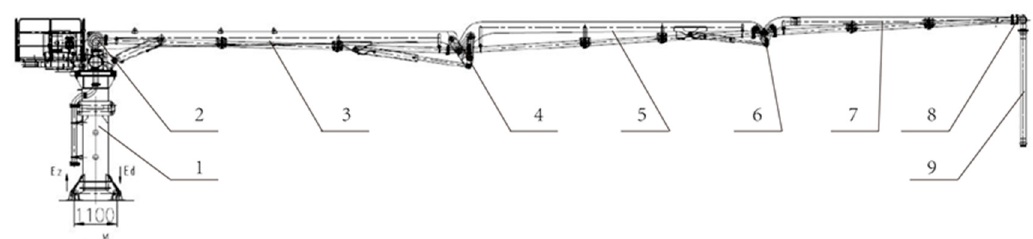
Figure 1. Structure diagram of the mobile concrete pump manipulator. 1. Rotation base; 2. 1st joint; 3.